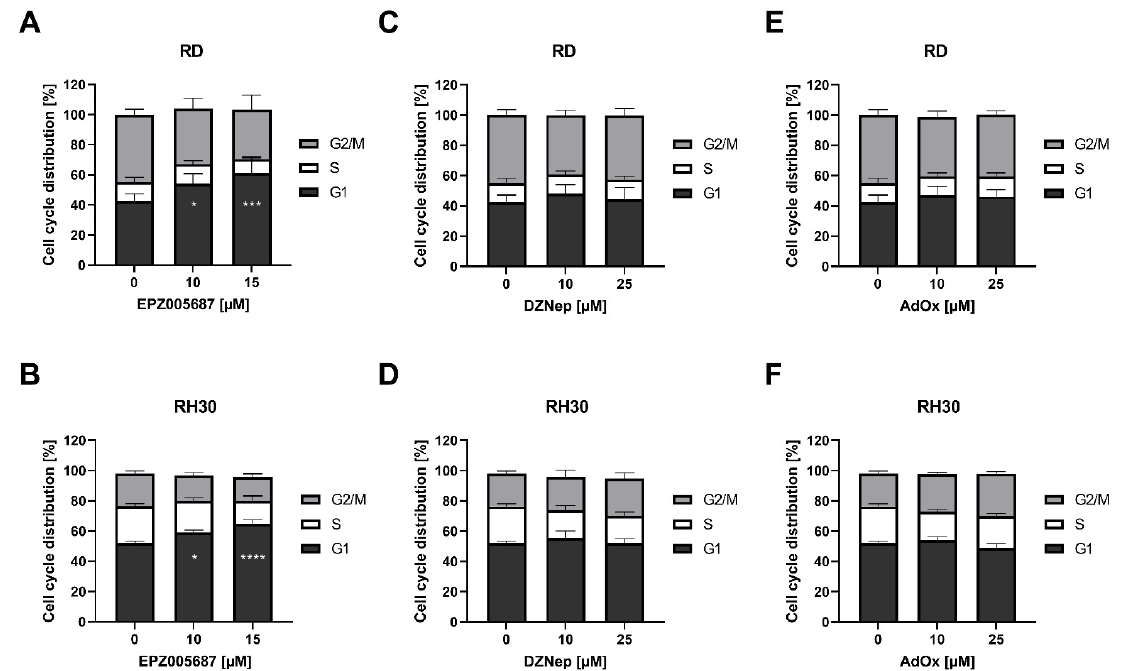
Figure 6. Flow cytometric analysis of cell cycle in RMS cell lines. Effect on cell cycle arrest following a 72 h incubation in the presence (black bars) or absence (white bars) of EPZ005687 ( A , B ), DZNep ( C , D ), and AdOx ( E , F ) on RD (upper row) and RH30 cells (lower row). Error bars represent mean +/ − SEM ( n = 4). p * ≤ 0.05, p *** ≤ 0.001, p **** ≤ 0.0001 indicates statistical significance.